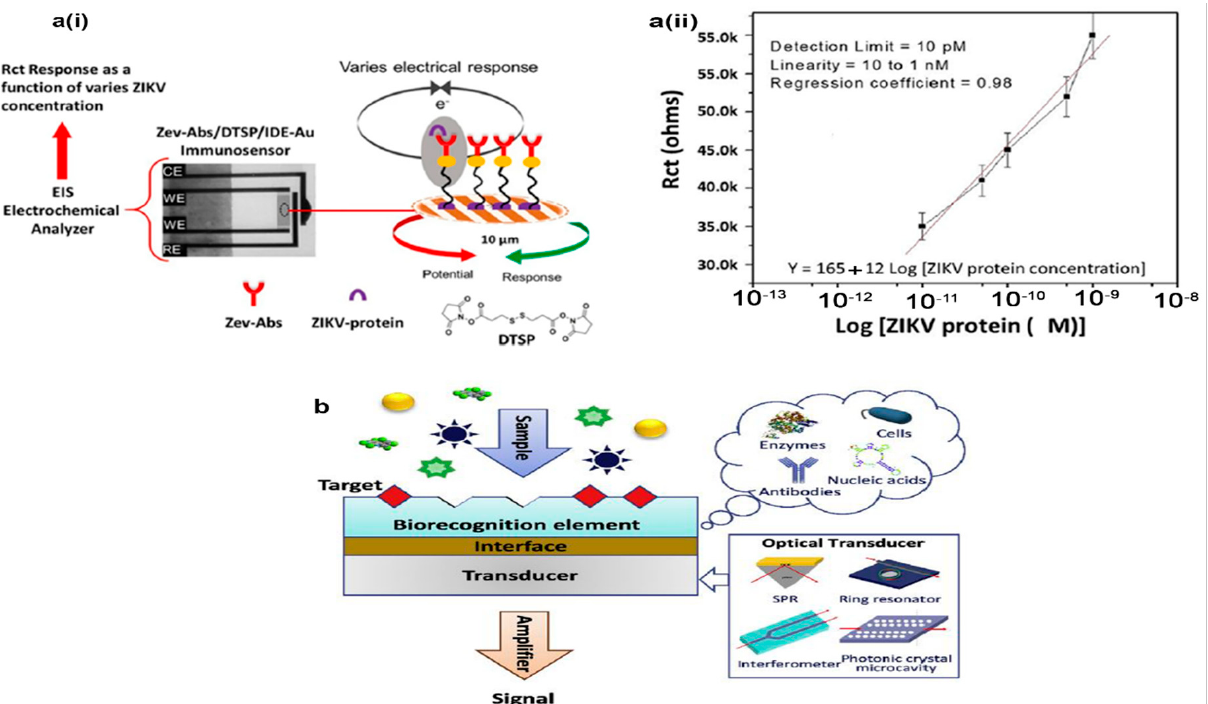
Figure 2. Schematics of the electrochemical ( a ( i ) and a ( ii )) and optical ( b ) sensors that are used for virus detection: a ( i ) picture of the impedance-based electrochemical immunosensor and a ( ii ); Dependence of the charge transfer resistance on the virus concentration from 10 pM to 1 nM. ( b ) Schematic diagram of optical biosensor constitution and its components. The figures were reprinted with permission from refs [96,108], Copyright 2019, Elsevier and Copyright 2020, Elsevier.